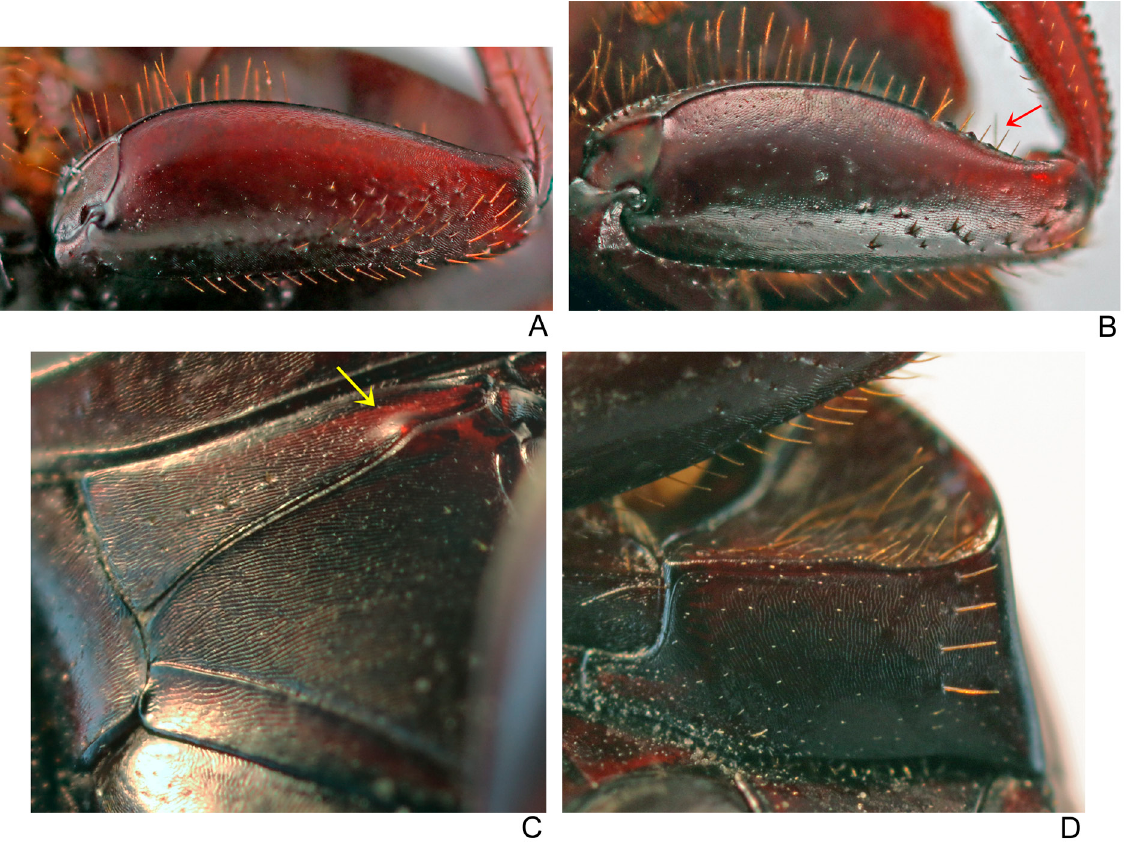
Fig. 9. A . Sylvicanthon bridarollii (Martínez, 1949), profemur. Note that, as occurs in the other species of the candezei group, there is no denticulation on the anterior edge, which is, by contrast, completely smooth. B . S. enkerlini (Martínez et al. , 1964) comb. nov., profemur. Arrow indicates the denticulation of anterior edge, a condition present in both sexes and unique in the genus. C . S. enkerlini , metepisternum. Arrow indicates the small tubercle at the suture between metepisternum and the lateral region of metaventrite. D . S. enkerlini , hypomeron. Notice the row of long setae present on the lateral of posterior region, a condition seen uniquely in this species in Sylvicanthon